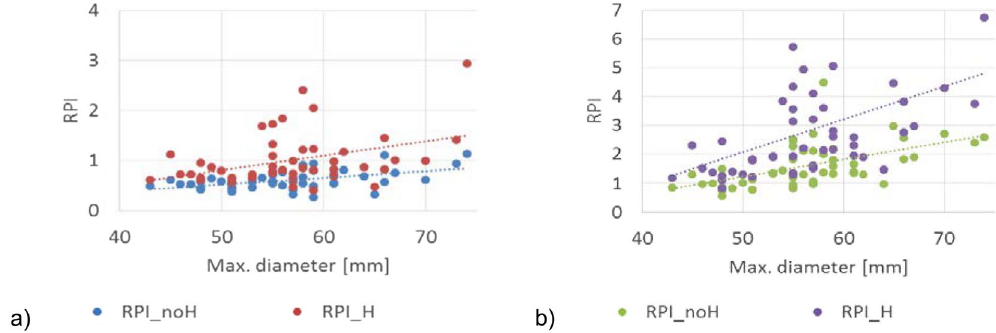
Figure 8. Influence of AAA diameter, ILT, and family history of AAA on the computed RPI. ( a ) RPI computed in the “ILT pressure” scenario, with (R 2 = 0.16) and without (R 2 = 0.25) considering a family history of AAA for each case. ( b ) RPI computed in the “No ILT” scenario, with (R 2 = 0.18) and without (R 2 = 0.3) considering a family history of AAA for each